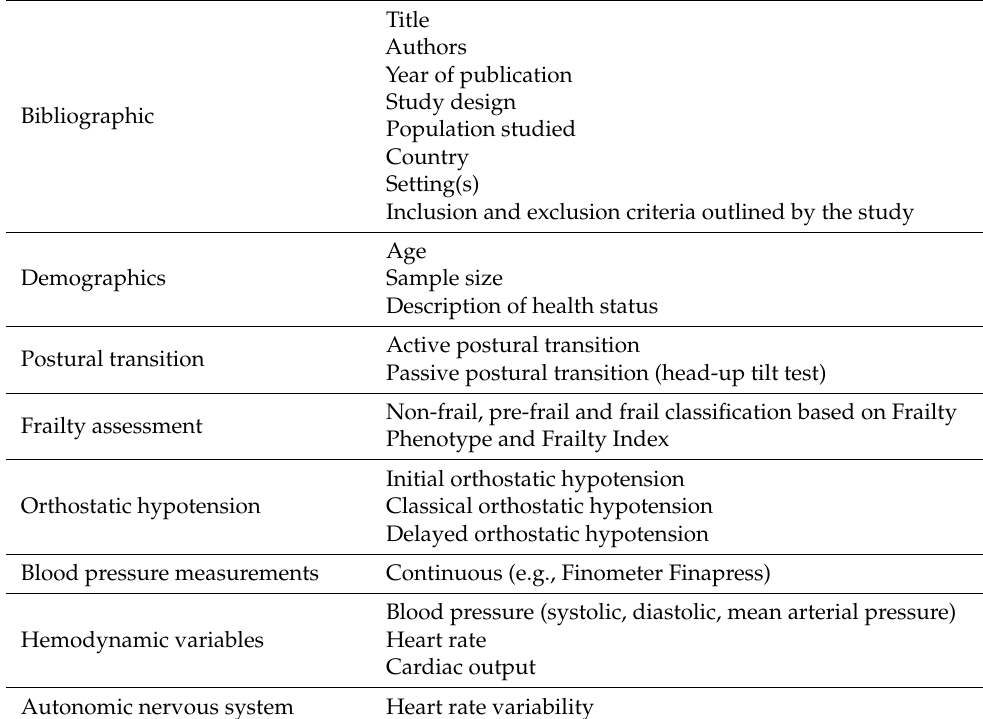
Table 1. Variables to be extracted at the full